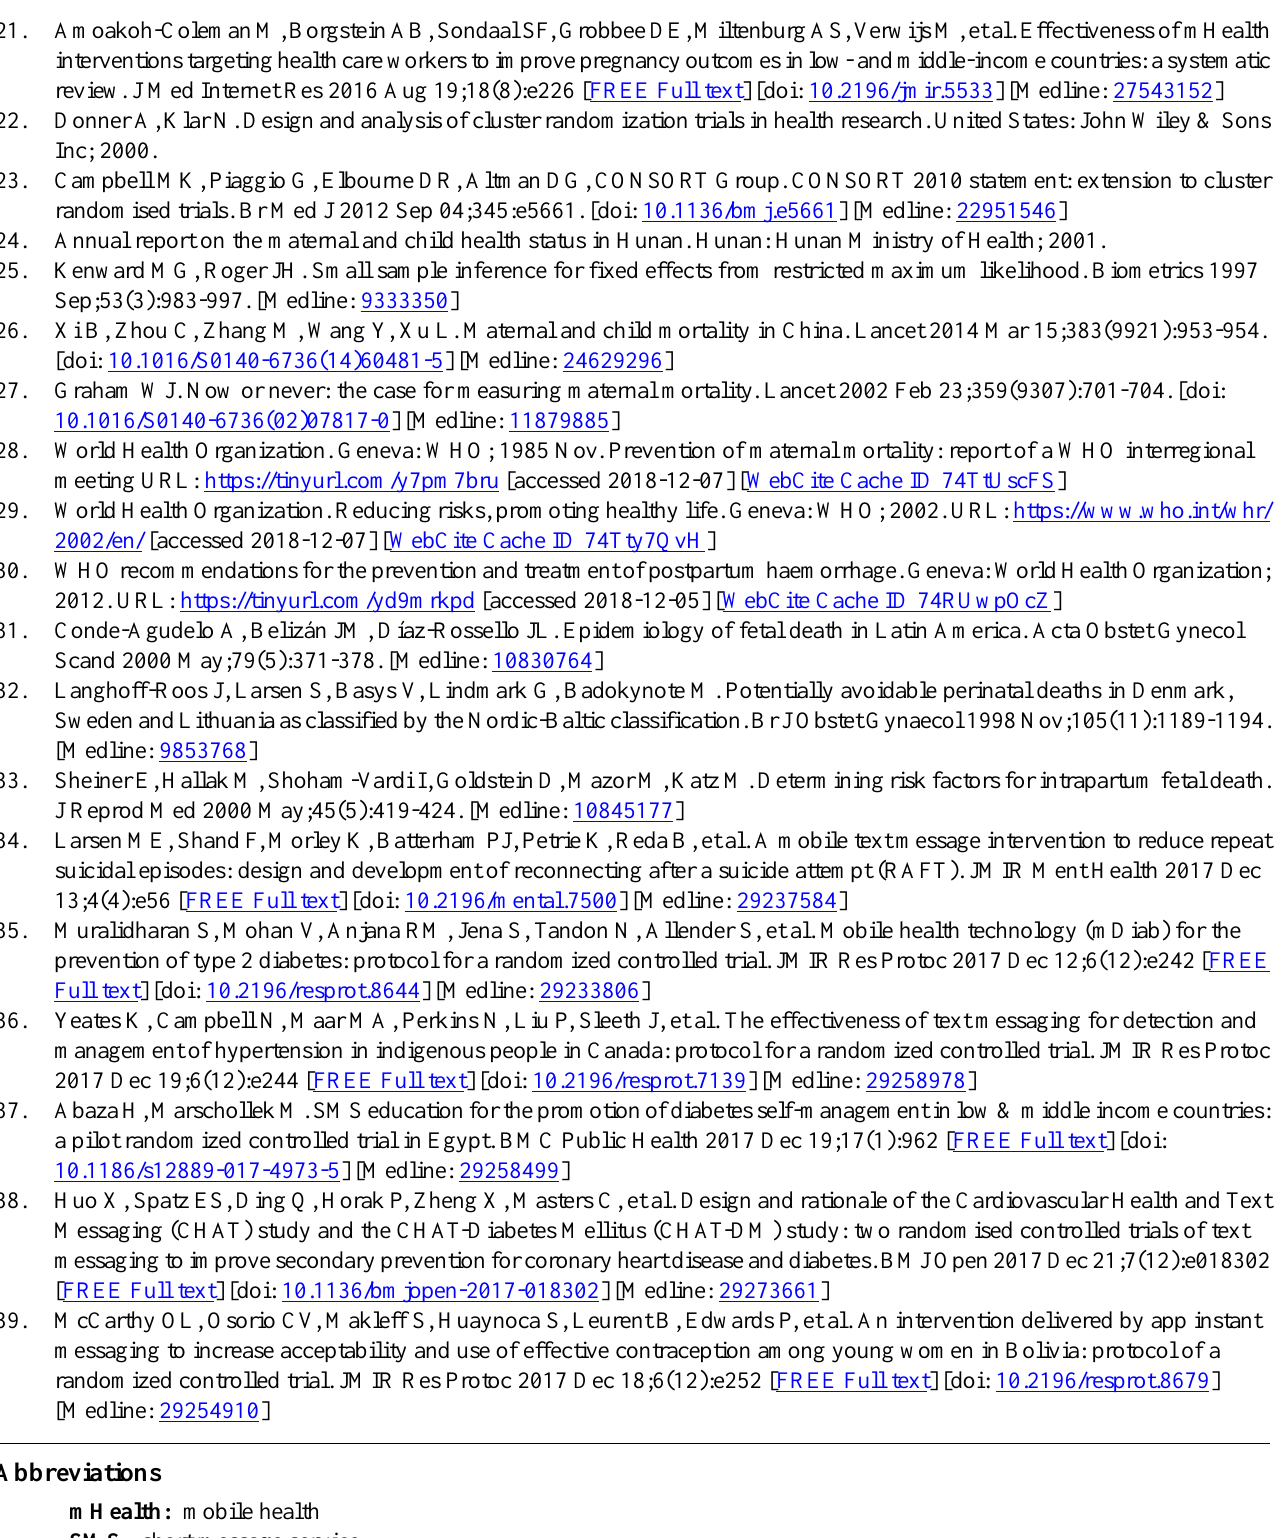
SMS: short message service WHO: World Health